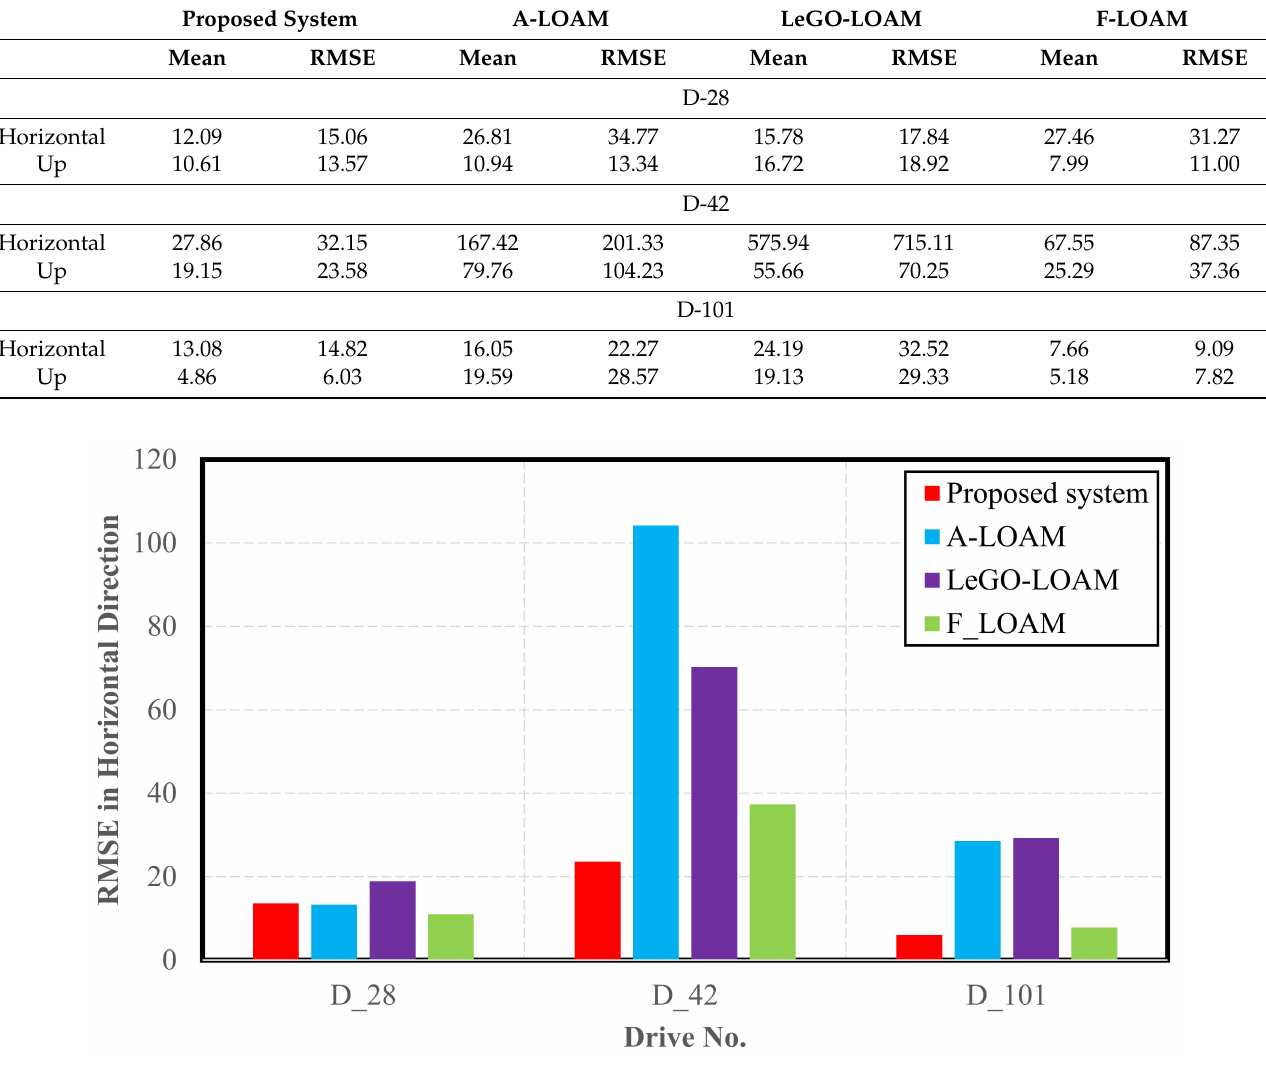
Figure 27. Performance comparison between the proposed integrated system and state-of-the-art SLAM algorithms (RMSE in horizontal